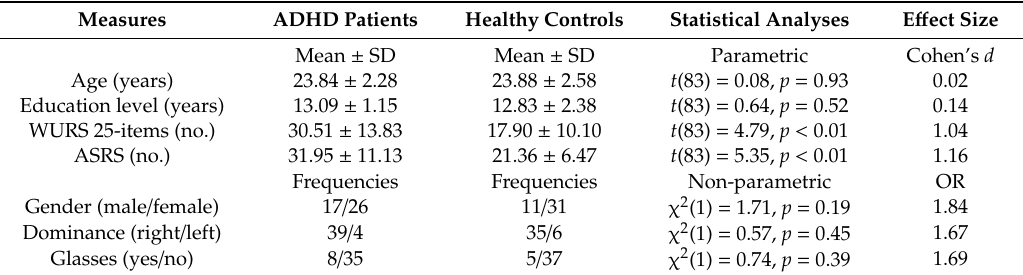
Table 1. Demographic and clinical data of attention-deficit / hyperactivity disorder (ADHD) patients ( n = 43) and healthy controls ( n = 42).